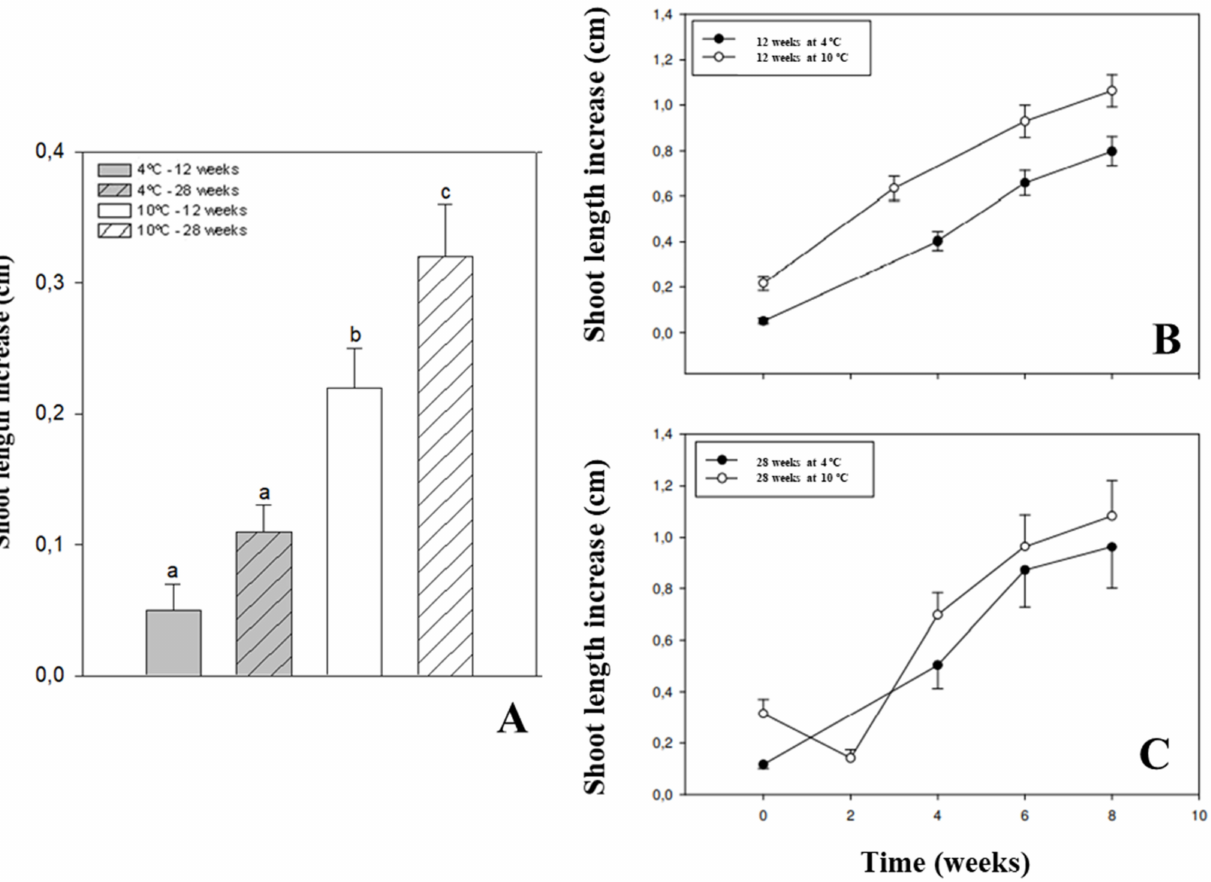
Figure 5. Medium-term conservation experiments for Tetraclinis articulata (Vahl) Masters in vitro cultured explants. The effect of two temperatures (4 ◦ C and 10 ◦ C) and two storage times (12 and 28 weeks) in dark conditions (stage 1) was evaluated on explants’ length increase, monitored during 8 weeks of culture onto fresh SH medium at 25 ± 1 ◦ C under an active radiation of 42 µ mol m − 2 s −